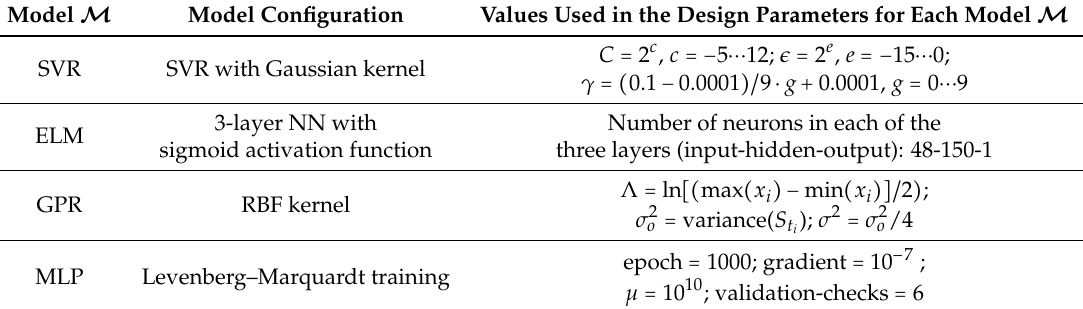
Table 3. Configuration and design parameters of the regression ML models M explored in the proposed approach for all the wind farms considered. See Section 5 for further